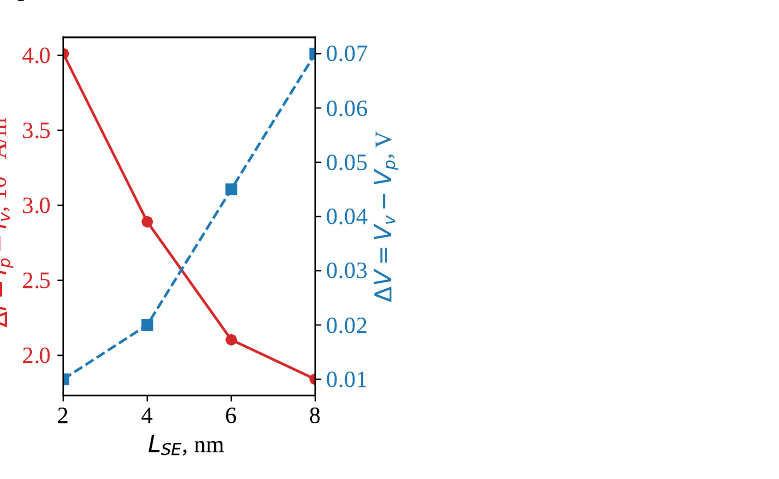
Figure 10. Dependences of ∆ I = I p − I v (red line, left Y -axis) and ∆ V = V v − V p (blue line, right Y -axis) on the thickness of the emitter spacer for RTD Structure #1 at L SC = 3